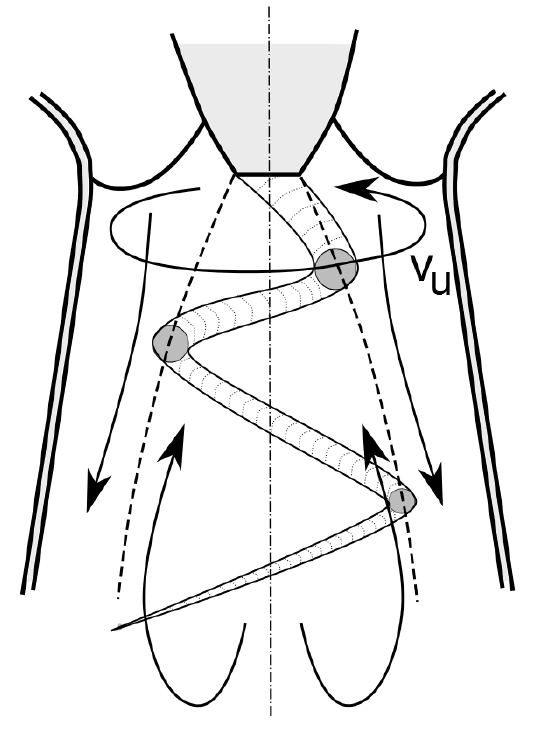
Fig. 3. Spiral vortex breakdown (dashed line marks the shear layer)